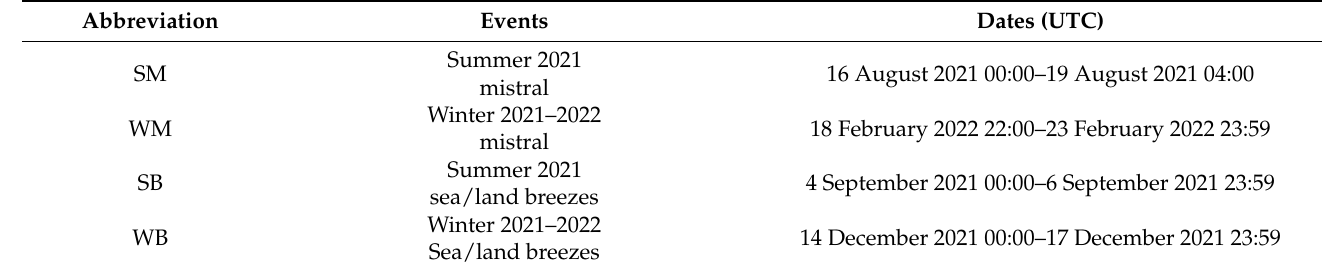
Table 4. Short name, season, wind regime, and period for each of the four studied events.